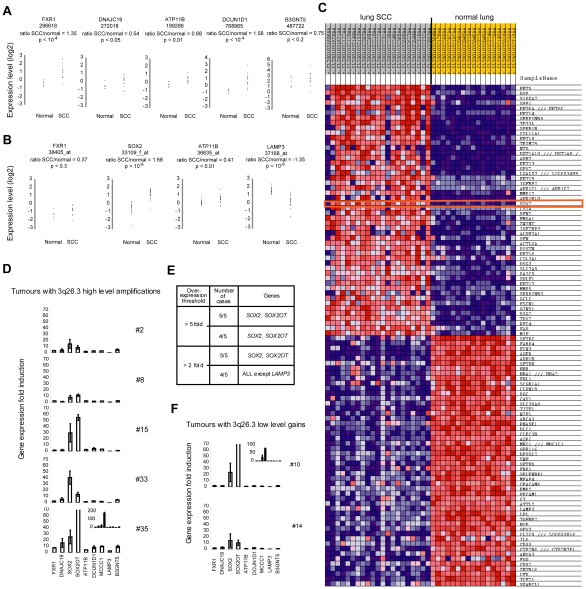
Transcriptional consequences of 3q26.33 copy number increases in lung SCC.Panels A and B: expression levels of 3q26.33 genes in lung SCCs versus normal comparisons using microarrays and Oncomine. Each graph represents normalized log2 expression values of a given gene in normal lung and lung SCC samples. The clone (panel A) or Affymetrix probe set (panel B) number is indicated under the gene name. The log2 value ratio (average expression value in SCC)/(average expression value in normal lung) and the corresponding p-value are indicated. A. Lung SCC dataset-2. Among the five genes that were analyzable and represented (FXR1, DNAJC19, ATP11B, DCUN1D1, and B3GNT5), FXR1, ATP11B, and DCUN1D1 are significantly over-expressed in lung SCCs (all with p<10−2). B. Lung SCC dataset-1. Four genes localized in the 3q26.3 core amplicon are represented on the microarray (FXR1, SOX2, ATP11B, and LAMP3). LAMP3 is strongly down-regulated in the tumors (p<10−8). ATP11B (p<10−2) and SOX2 (p<10−8) are significantly over-expressed in lung SCCs. C. Top 100 genes deregulated in lung SCC dataset-1 using GenePattern. These genes include SOX2 (red rectangle) among the top 50 genes over-expressed in lung SCCs compared to normal lung. In this dataset, four genes (FXR1, SOX2, ATP11B, and LAMP3) out of the nine localized in the core amplicon were represented on the array. For each gene in each sample, expression is represented by a square with a color that codes for the level as a gradient (dark blue, low expression, to dark red, strong expression). D. Expression levels of nine genes from the consensus region in the tumors with high level 3q26.3 amplifications. The identical y-scale for all graphs represents the expression ratio for a given gene when compared to its relative average expression level in two lung SCCs without copy number change of the 3q26.3 locus. Genes are ranked from left to right according to 3q26.33 genomic localization, and names are represented below the bottom graph. E. Summary of over-expressed genes in the five lung SCCs with high-level 3q26.3 amplifications. Two genes, SOX2 and SOX2OT, are consistently over-expressed in tumors with 3q26.3 copy number increases when compared to tumors with a normal copy number of the locus. Other genes are recurrently over-expressed but at lower levels when compared to SOX2 and SOX2OT. F. Two tumors with low-level copy number gains of the 3q26.3 locus were analyzed as in panel D. SOX2 and SOX2OT are the most over-expressed genes in these tumors. Panels D and F: Sample numbers are indicated on the right of the graphs. Insets in tumor #35 and #10 graphs correspond to y-axis extended scale to fold-change values of 200 and 100, respectively. Fold-changes represent the mean ± sem of three independent experiments.